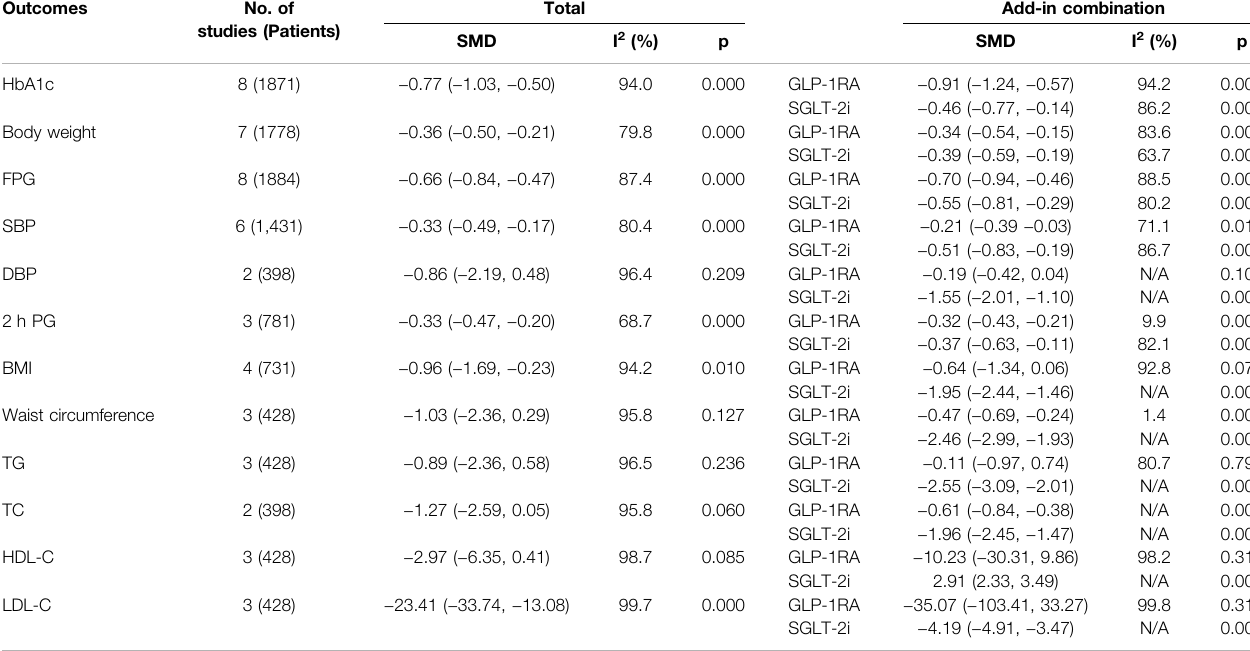
TABLE 2 | Total results and subgroup results for all ef fi cacy measures that considered of the included studies. Outcomes No. of studies (Patients)